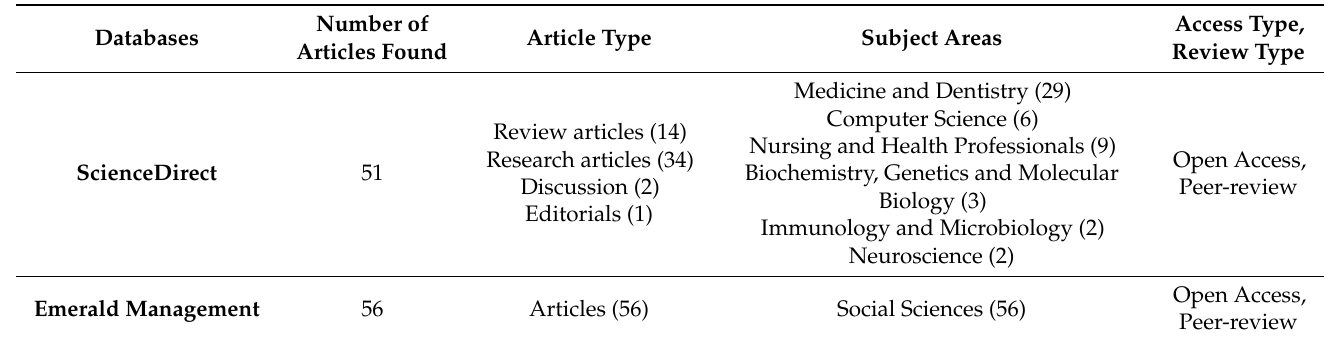
Table 1. Search sources and